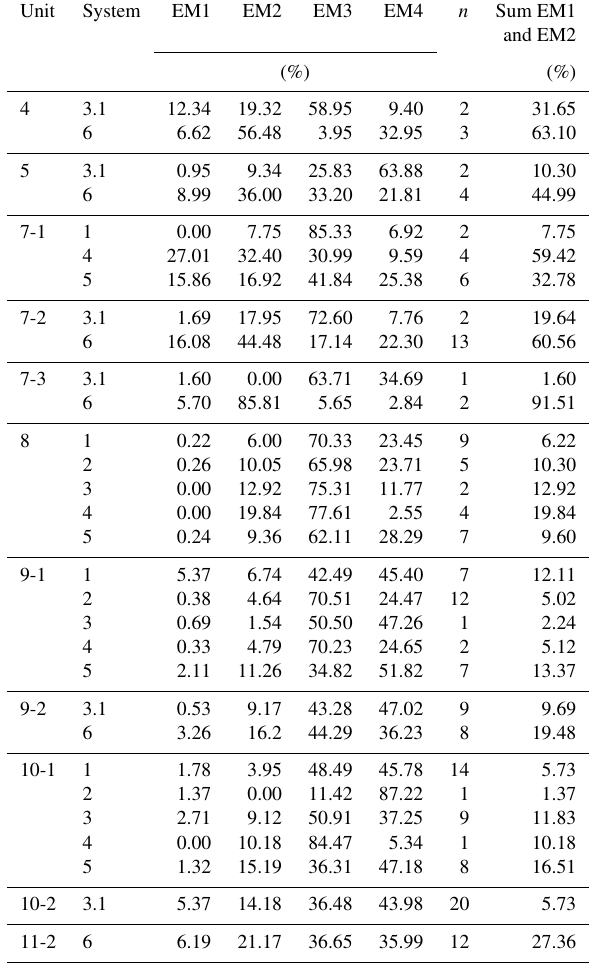
Table 3. Endmember data organised in units and subunits, specified by